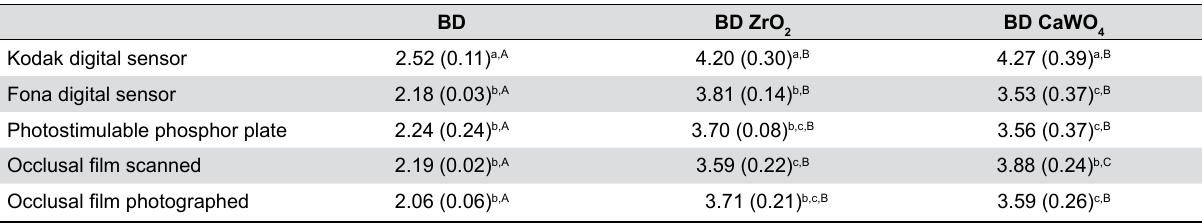
Table 1- Mean and standard deviation of the radiopacity values of the materials (mm Al) evaluated by digital or convectional radiography systems